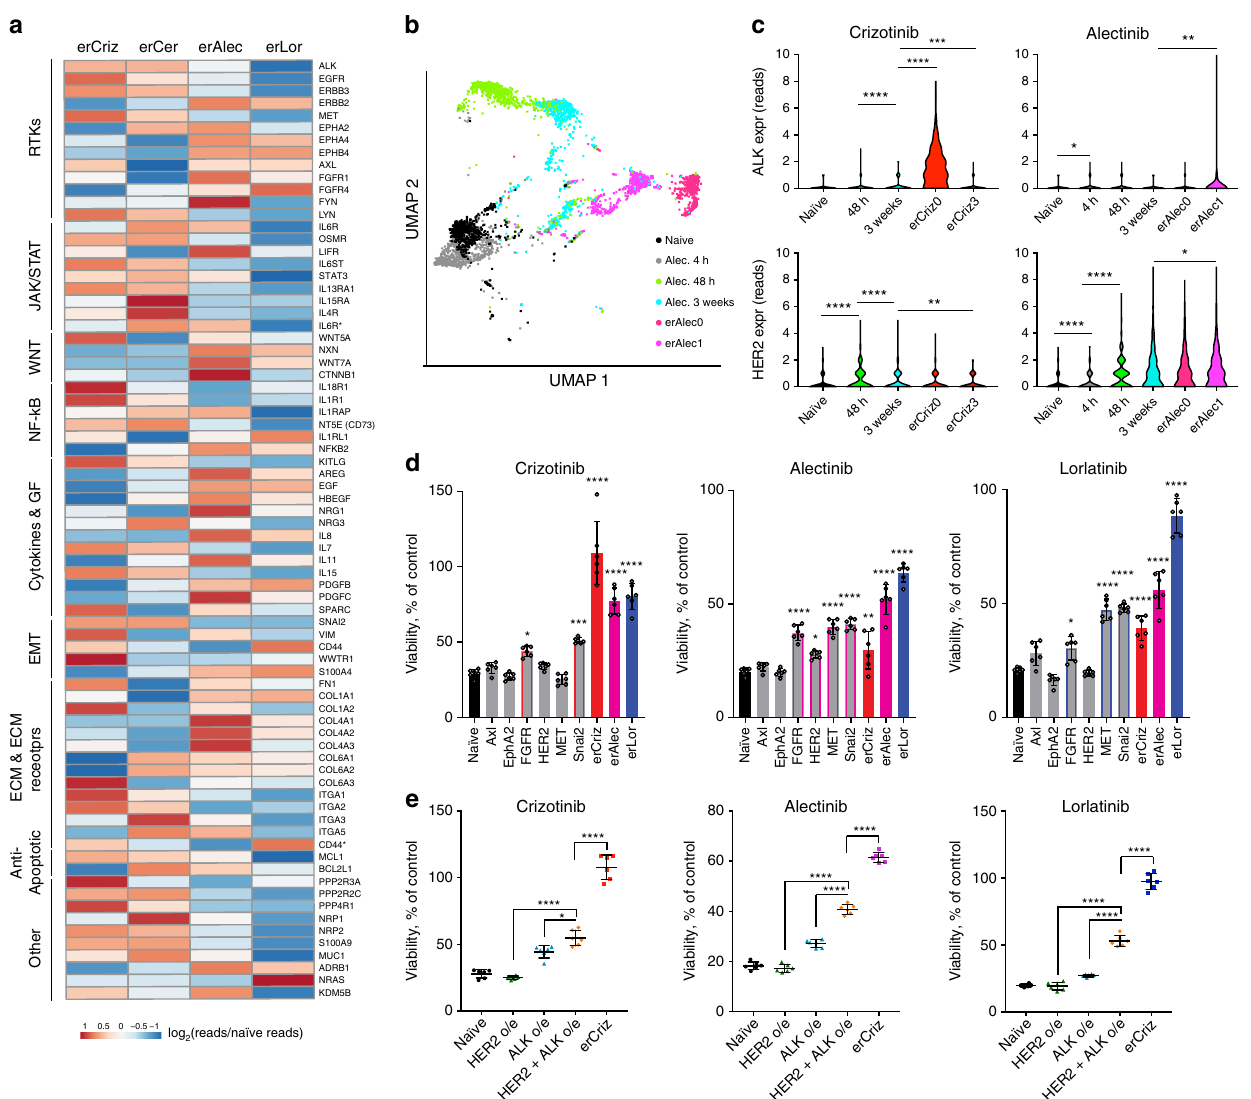
Fig. 5 ALK-TKI resistance integrates multiple mechanisms. a Normalized mRNA expression for the indicated genes, previously associated with chemotherapy or targeted therapy resistance, in erALK-TKI cell lines across the indicated functional categories. b UMAP analysis of single-cell mRNA expression data from cells exposed to 0.5 μ M alectinib for the indicated time duration. c Violin plot of expression levels of ALK and HER2 following indicated duration of exposure to the indicated ALK-TKIs. * p < 0.05, ** p < 0.01, *** p < 0.001, and **** p < 0.0001 of a Mann – Whitney U -test. d ALK-TKI sensitivity of engineered cell lines, lentivirally overexpressing indicated genes to the indicated ALK-TKIs (0.5 μ M), as determined by Cell Titer Glo assay. Mean± SD of experimental replicates ( n = 6, representing separate wells) are shown. e Impact of combination of individual resistance mechanisms toward sensitivity to indicated ALK-TKIs (0.5 μ M), determined by Cell Titer Glo assay. * p < 0.05, ** p < 0.01, *** p < 0.001, and **** p < 0.0001 of ANOVA analysis with Dunnett ’ s ( d ) or Tukey ’ s ( e ) multiple comparison correction. Mean± SD of experimental replicates ( n = 6, representing separate wells) are